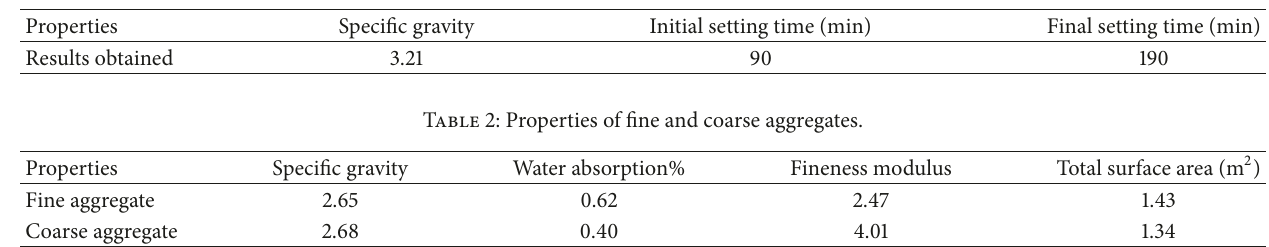
Table 1: Properties of ordinary Portland cement.